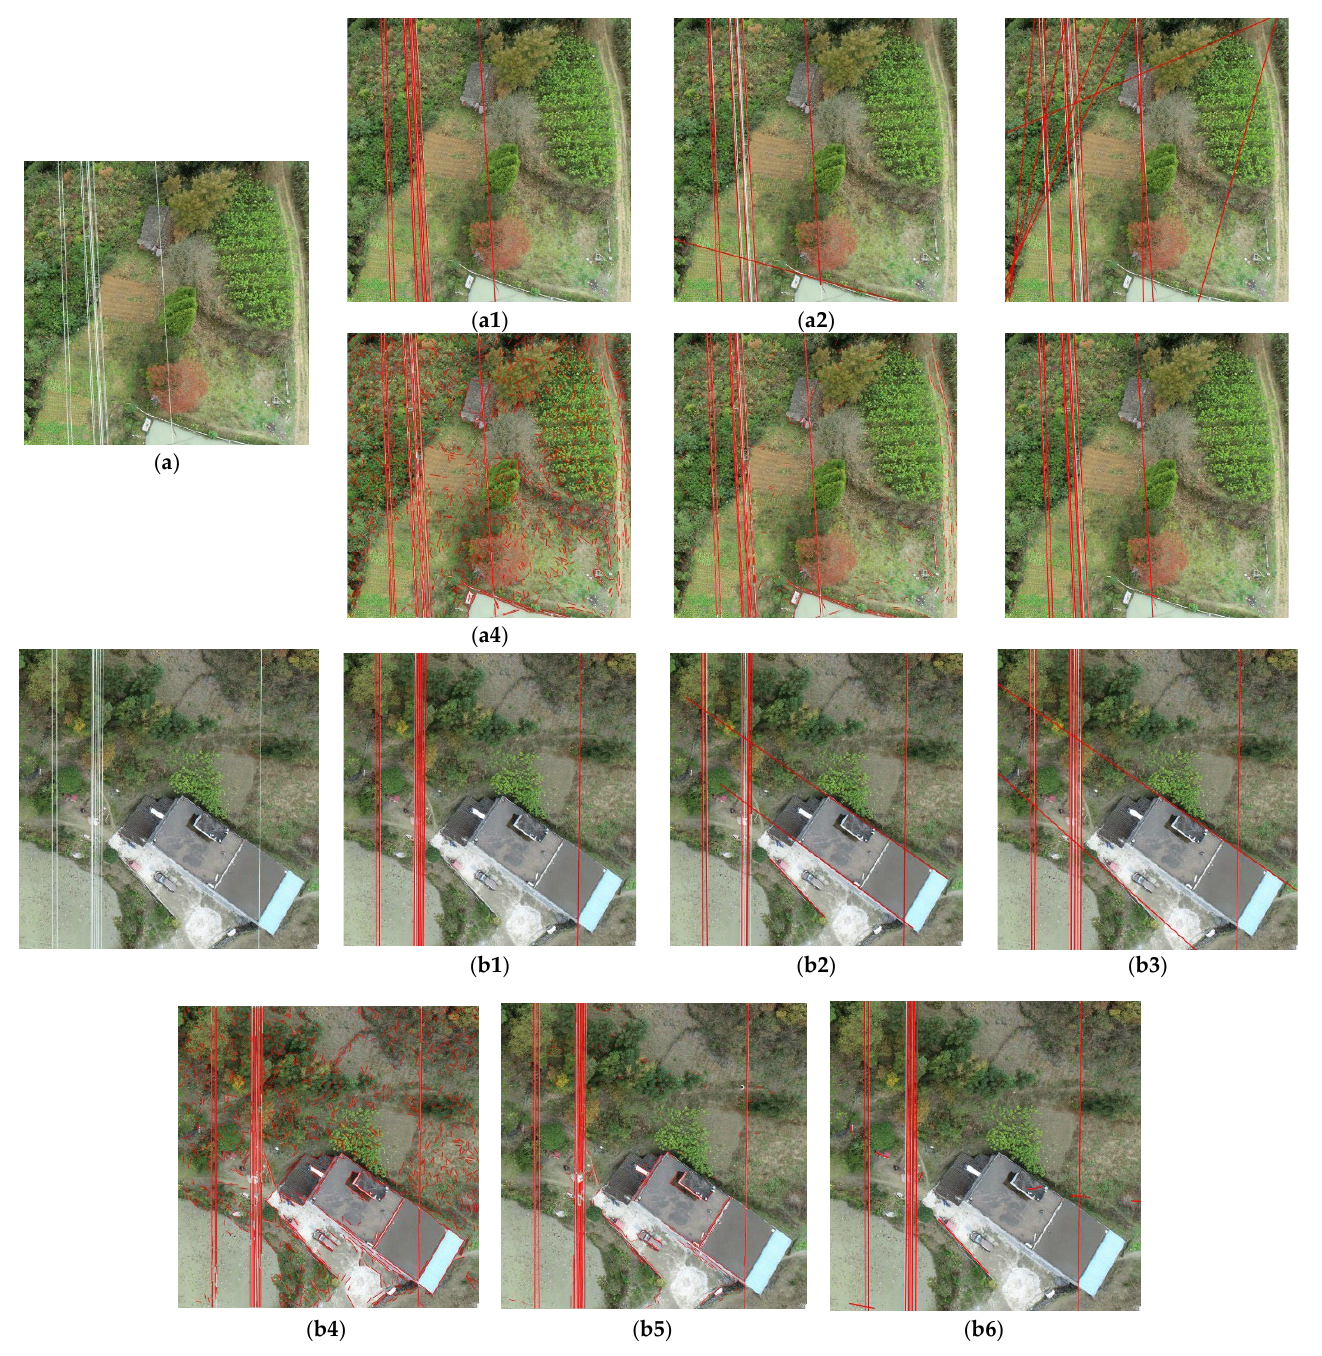
Figure 16. Extraction results for high IC images: ( a , b ) are the original images; ( a1 , b1 ) are the ground truth; ( a2 , b2 ) are the results of the IHT method; ( a3 , b3 ) are the results of the CRT method; ( a4 , b4 ) are the results of the OLSD method; ( a5 , b5 ) are the results of the LSD-OMRF method; and ( a6 , b6 ) are the final fitting results of the method proposed in this paper.